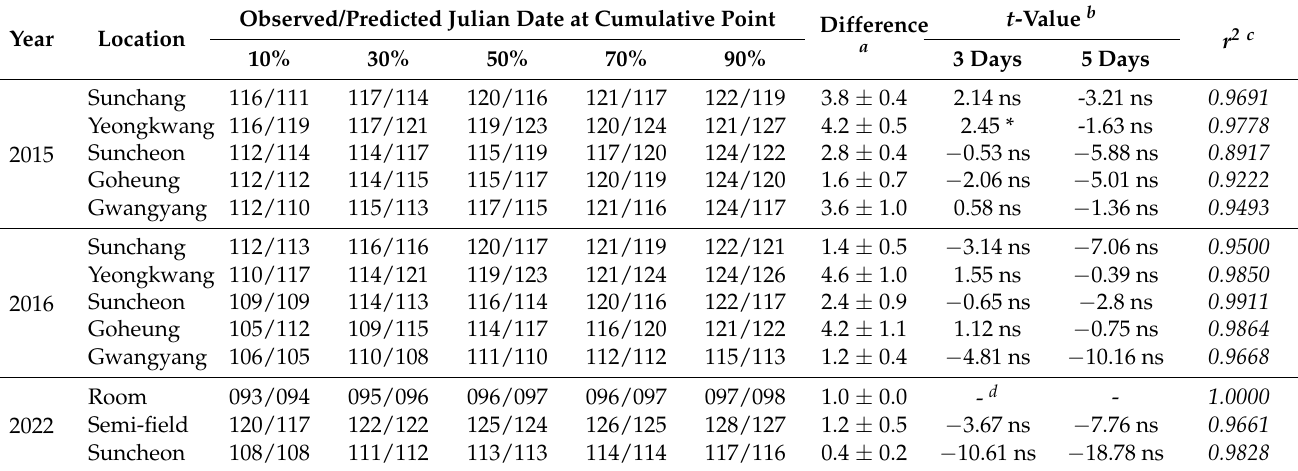
Table 5. Accuracy of the spring model in forecasting the Julian date of cumulative flight of Eurytoma maslovskii